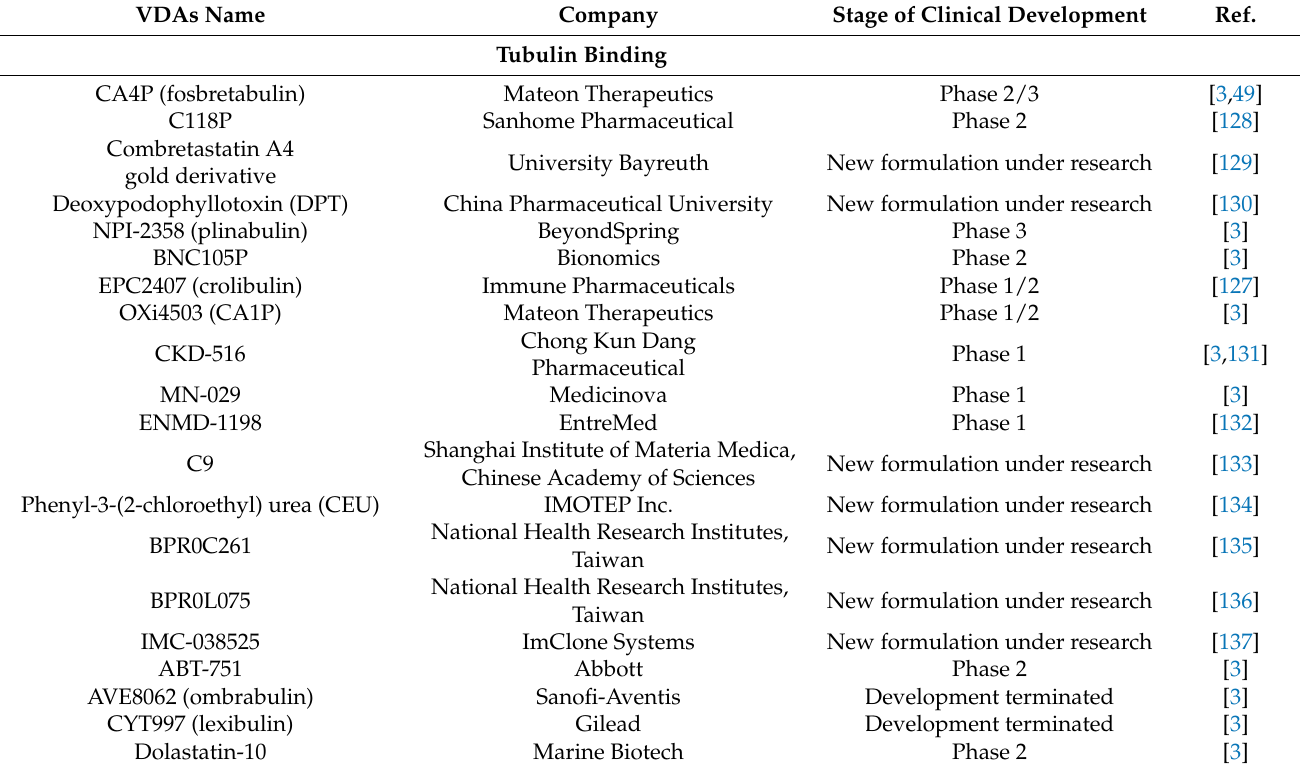
Figure 8. Schematic mechanisms of tumour vascular-targeting tubulin-binding agents. Table 6. Vascular-disrupting agents (VDAs) and developmental